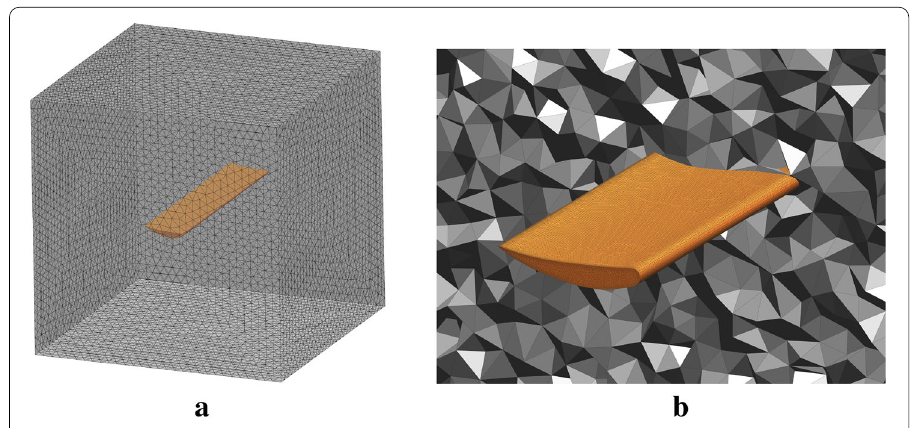
Fig. 24 Model setup to test the proposed refinement strategy with regard to possible improvements in the approximation of immersed objects. a Overall model setup with wing placed into a background mesh.